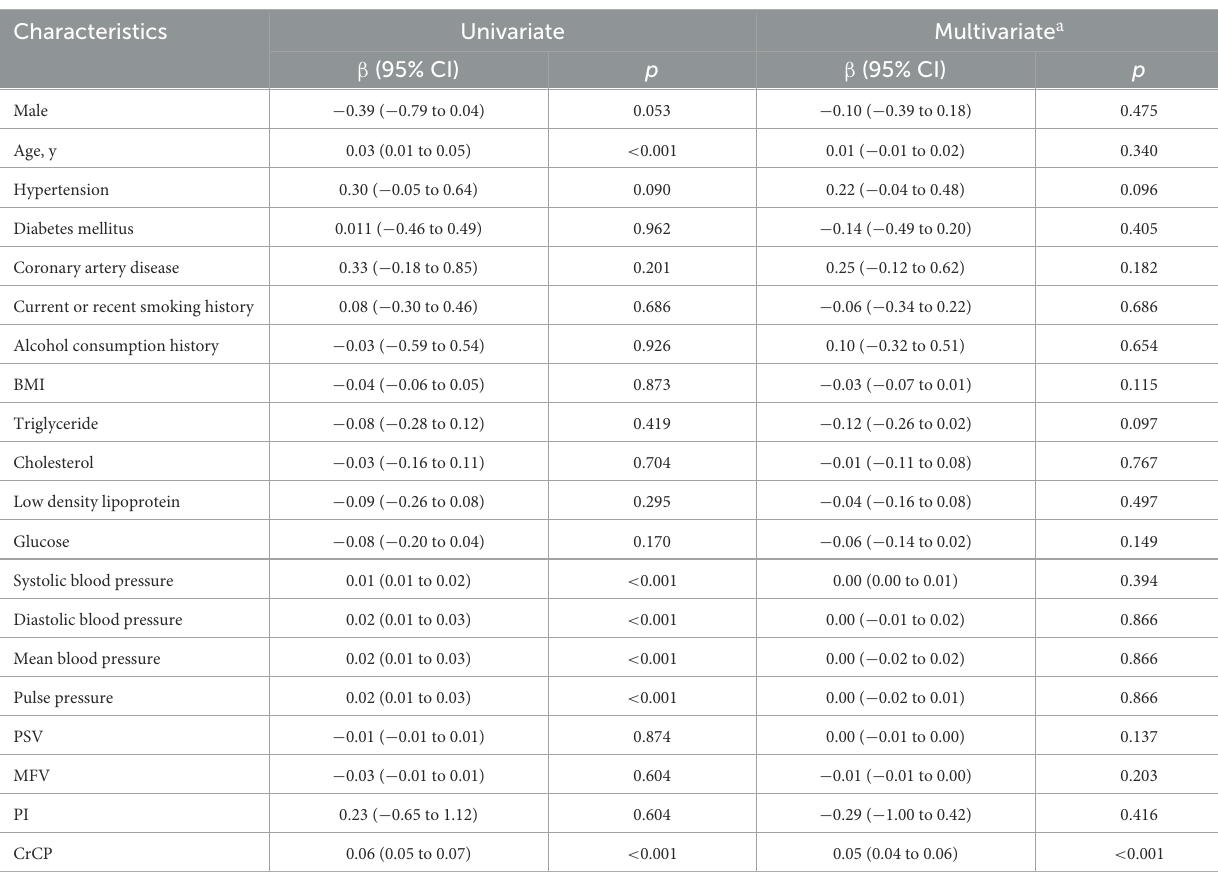
TABLE 3 CSVD burden association with demographics and baseline characteristics.